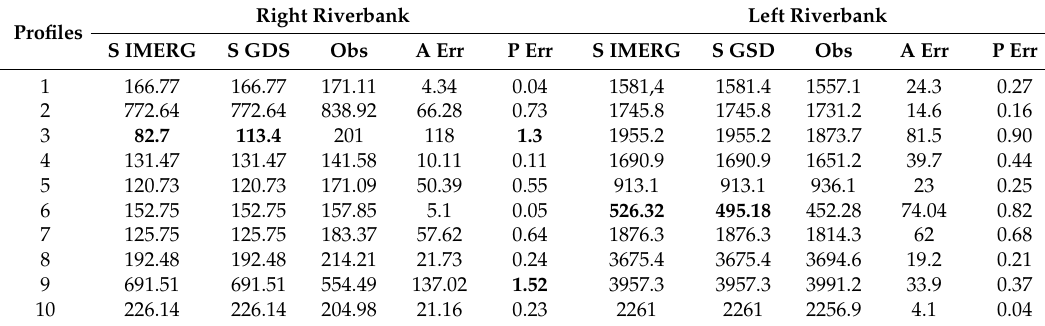
Table 5. Accuracy assessment of simulation flood